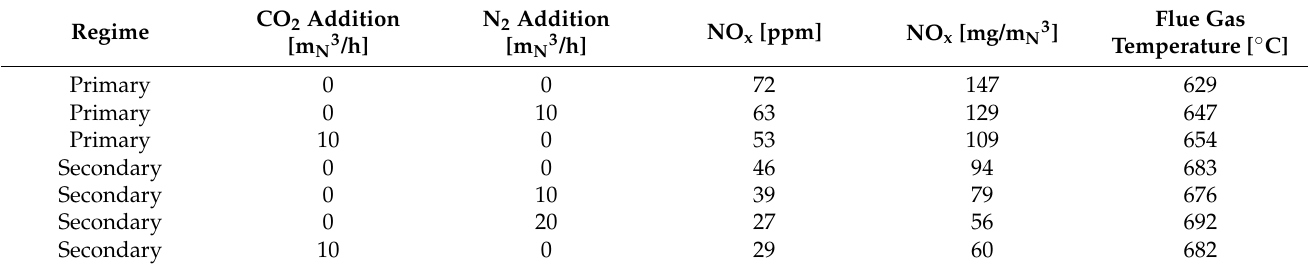
Table 3. Experimental matrix—TEST A—Burner